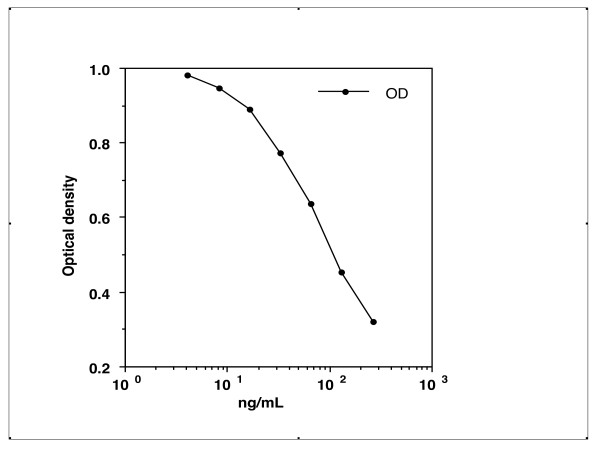
Standard curves for chicken CA-III concentrations generated by use of the competive ELISA specific for chicken CA-III. Typical standard curves were plotted for a range of CA-III solutions (2-400 ng/mL). The coefficients of variation (CV) for these solutions were as follows: 400 ng/mL, CV = 4.3%; 200 ng/mL, CV = 4.8%; 100 ng/mL, CV = 2.4%; 50 ng/mL, CV = 6.8%; 25 ng/mL, CV = 3.6%; 12 ng/mL, CV = 3.1%; 6 ng/mL, CV = 2.4%. Values were obtained by using a spectroscope at 405 nm.